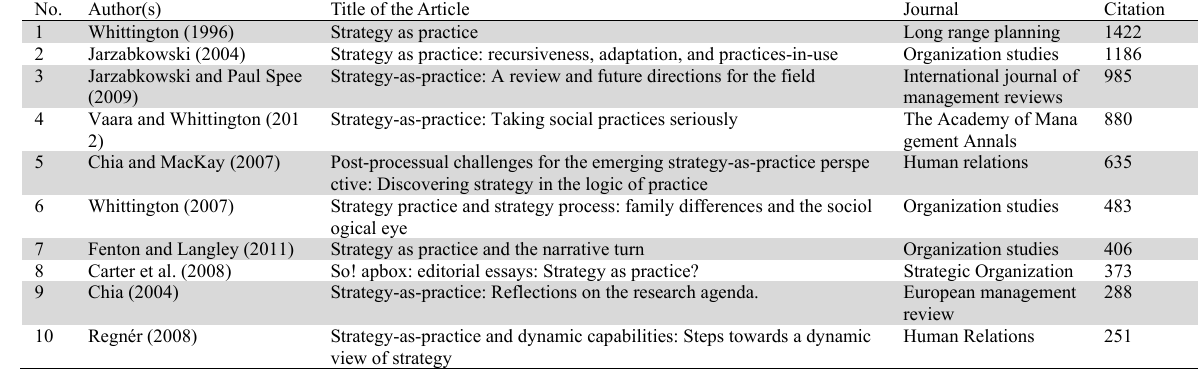
Most frequently cited articles on the concept of strategy-as-practice over the last twenty-three years (between 1996 and 2019) and according to the citation